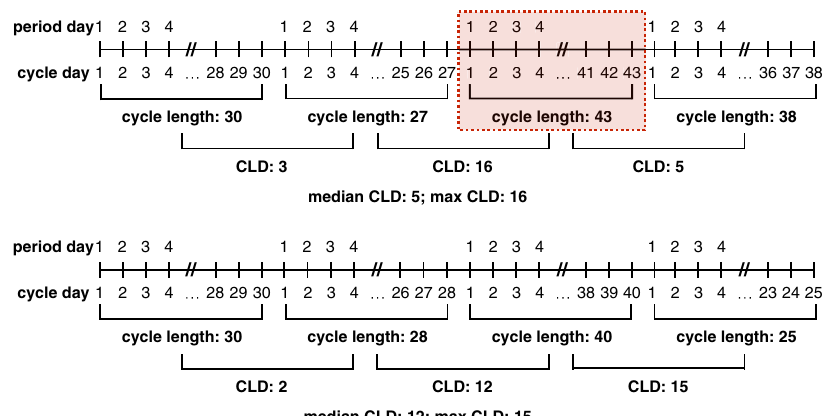
Fig. 7 Identifying cycle tracking artifacts and characterizing user regularity. We provide illustrative examples of identifying a cycle tracking artifact (top) and characterizing a user ’ s regularity (bottom) based on CLD statistics. In each example, we display a user ’ s cycle history with a total of four cycles. Cycle length is computed as the length of time between the fi rst day of a period and the fi rst day of the next period, and CLD is computed as the absolute difference between subsequent cycle lengths (i.e., if a user has n cycles tracked, they will have n − 1 CLD values). Period length is computed by counting the number of sequential days on which there is menstrual bleeding greater than spotting ( ‘ light, ’ ‘ medium, ’ or ‘ heavy ’ ). Two such sequences are considered one period if separated by no more than one day of non-bleeding/spotting. In the top example, the user ’ s second CLD exceeds their median by at least 10, and thus we identify the corresponding ‘ arti fi cally long ’ cycle in red — this cycle will be excluded from our analysis. In the bottom example, the user ’ s median CLD is at least 9, and thus they will be classi fi ed as a consistently highly variable user.